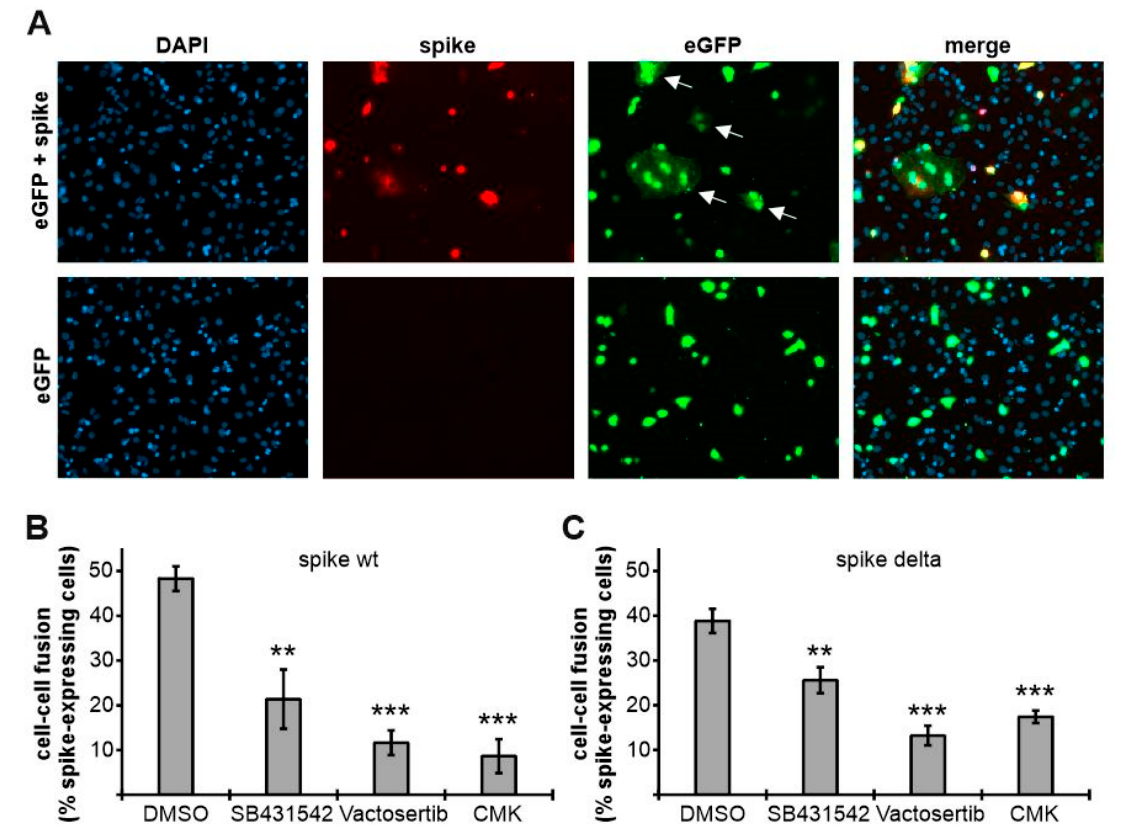
Figure 6. Attenuation of spike-mediated cell–cell fusion by ALK5 inhibition. ( A ) HEK293T cells transfected for two days with eGFP or both spike and eGFP were added onto Huh-7 cells. Two hours post addition, cells were analyzed by detecting the green fluorescent protein eGFP and spike protein (red) by utilizing an antibody directed against the spike S2 subunit. Nuclei were counterstained with DAPI (blue). White arrows indicate cell–cell fusion. ( B , C ) HEK293T cells, which were pre-treated overnight with 10 µ M of the indicated substances or the solvent control DMSO, were transfected for two days with ( B ) spike wt or ( C ) spike delta and eGFP and subsequently added onto Huh-7 cells. Two hours later, cells were analyzed for cell–cell fusion (% spike-expressing cells) by detecting eGFP as well as spike. Values are derived from biological triplicates and represent mean values ± SD. The p -values were calculated using two-tailed Student’s t -test. ** p ≤ 0.01; *** p ≤